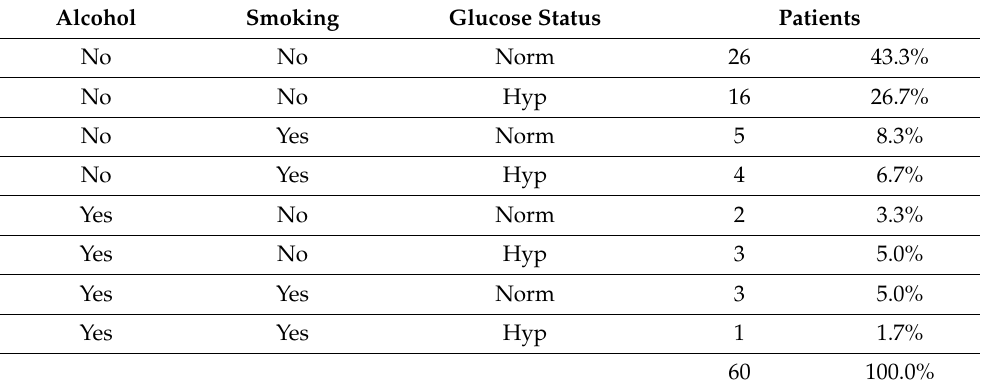
Table 4. Characteristics (bad oral habits and glucose status) of the necrosis group. Alcohol Smoking Glucose Status